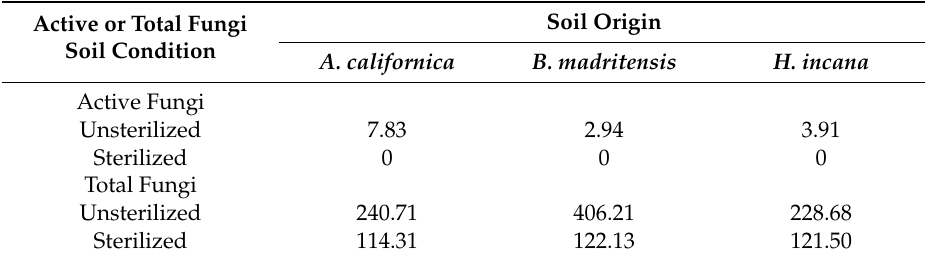
Table 1. Active and total fungal concentrations ( µ g / g) in six soil treatments. Soil was collected under three di ff erent plant species (soil origins), and soil from each origin was either sterilized or kept unsterilized (soil